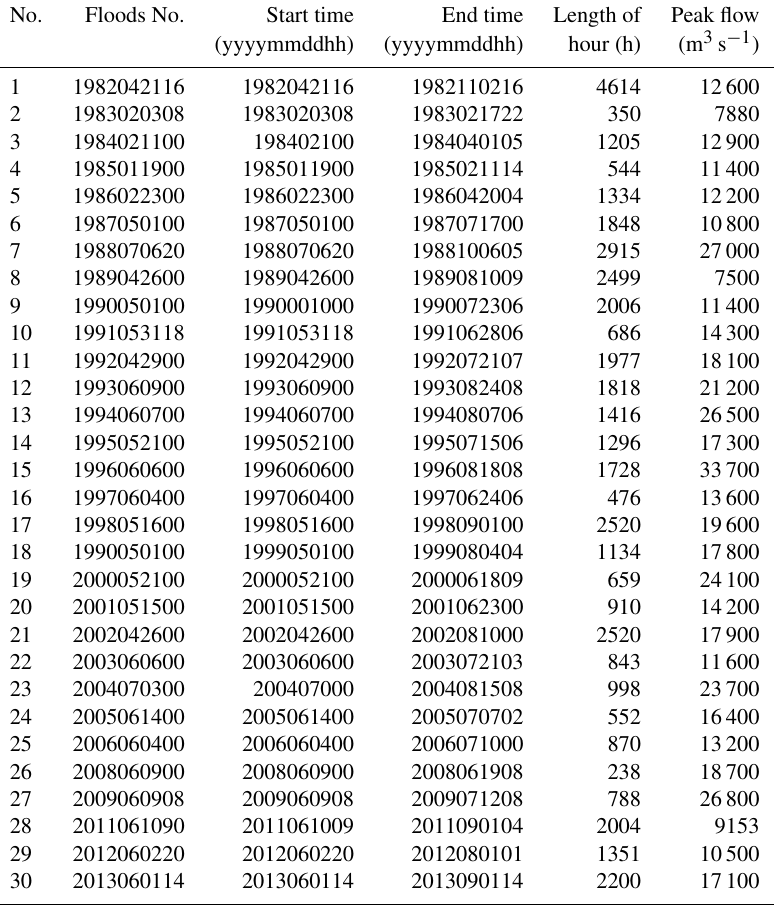
Table 1. Brief information of flood events in